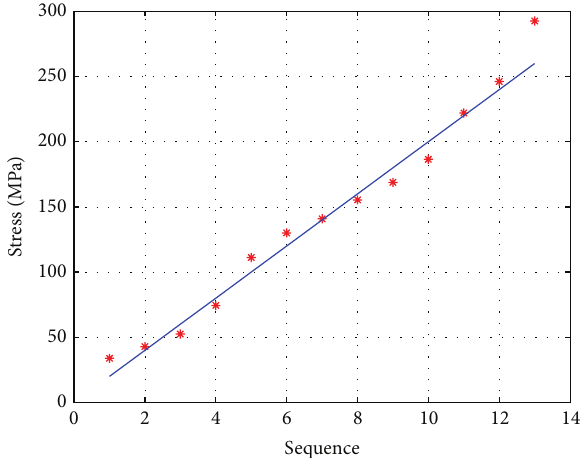
Figure 5: The comparison result of a 4.8 low-carbon steel bolt.